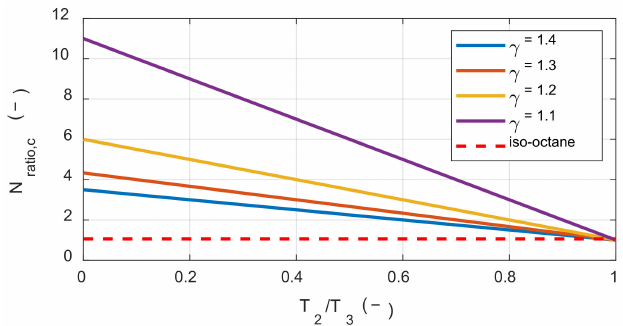
Figure 3. The critical molar ratio between the product and the reactant along with the temperature ratio and the specific heat ratio.